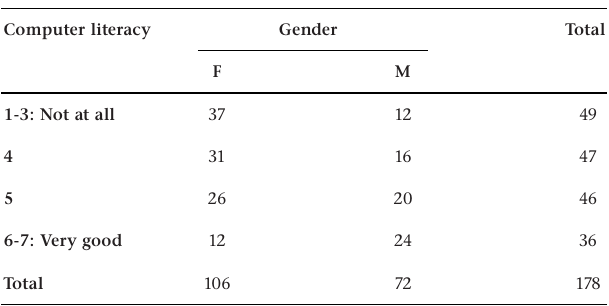
C ROSS TABULATION : GENDER VS COMPUTER